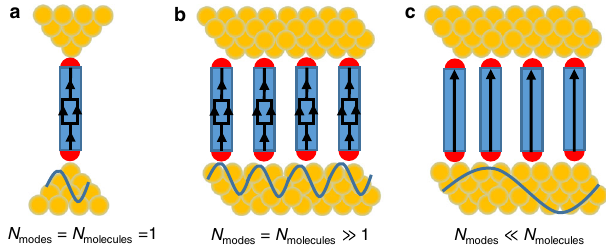
Fig.1|Intraversusinterquantuminterference.a Intra-molecularQIisaresultof thevariousinterferingpaths(MOs)ofasingletransverseconductancemodewithin the leads through a single molecule. b In MEJs, where the distance between molecules is comparable to the phase coherence length of the electrons at the Fermienergy,intra-molecularQIcanprevailineachmoleculebuttheensembleasa wholedoesnotcontributetotheinterferenceproperties. c Inter-molecularQItakes place in MEJs based on leads in which the electrons has a suf fi cient long λ F to coherently probe by tunneling large ensembles of molecules. Interference in this case depends on the tunneling phase of each of the molecules within the ensembles.